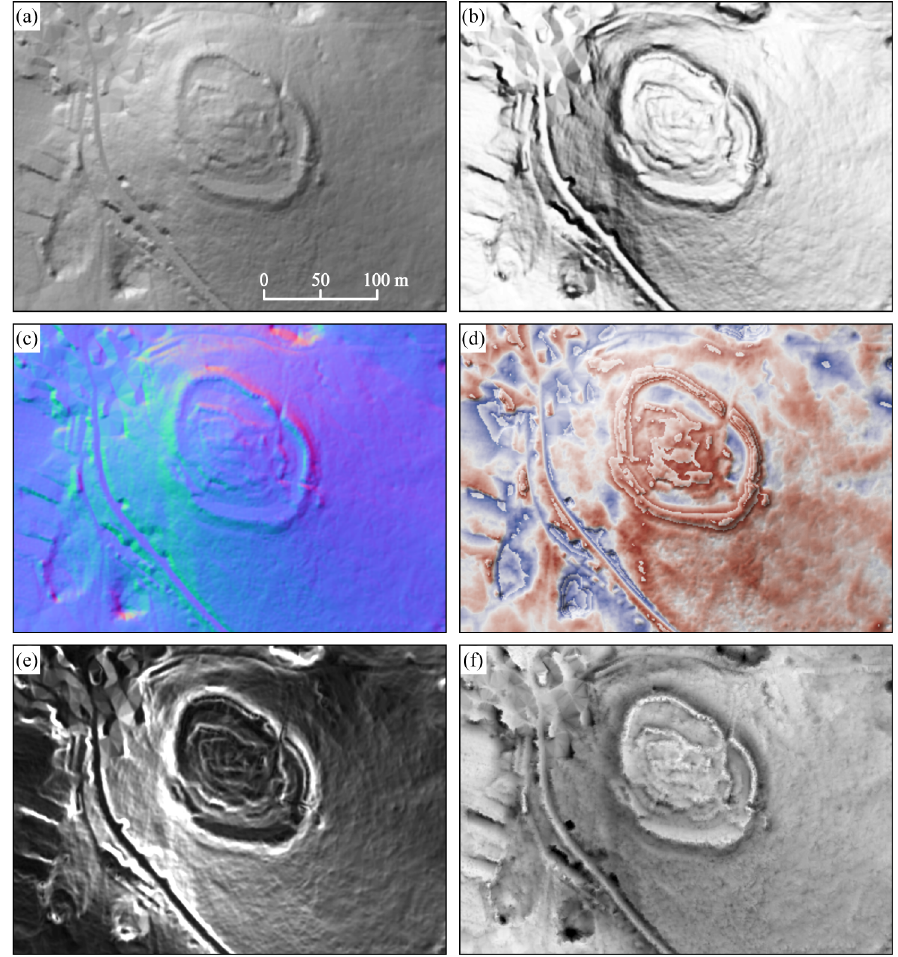
Figure 10. A comparison of visualization techniques used in archaeological interpretation for the area of Zagrajec Hill Fort, near Komen, Slovenia, a known yet un-excavated site. The images are produced by: standard analytical hill-shading (45° zenith angle, 315° azimuth; (a) ); the mean of analytical hill-shadings from 16 directions (b) ; a RGB composite of the first three components of the principal component analysis of analytical hill-shadings from 16 directions (c) ; trend removal and height coding by modulo distribution (±1 m, (d) ); Sobel edge detection (e) ; sky-view factor (10 m search radius in 16 directions, (f)